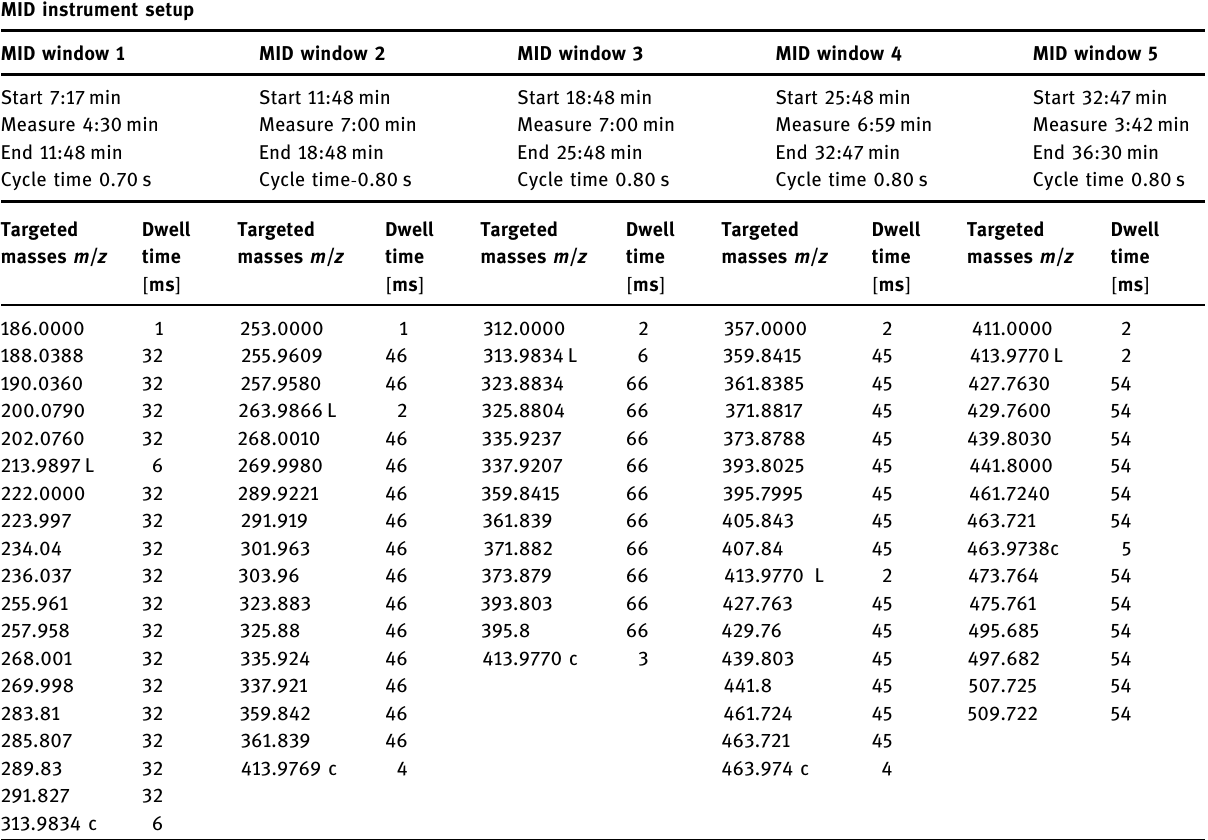
Table 1: MID for the PCB procedure MID instrument